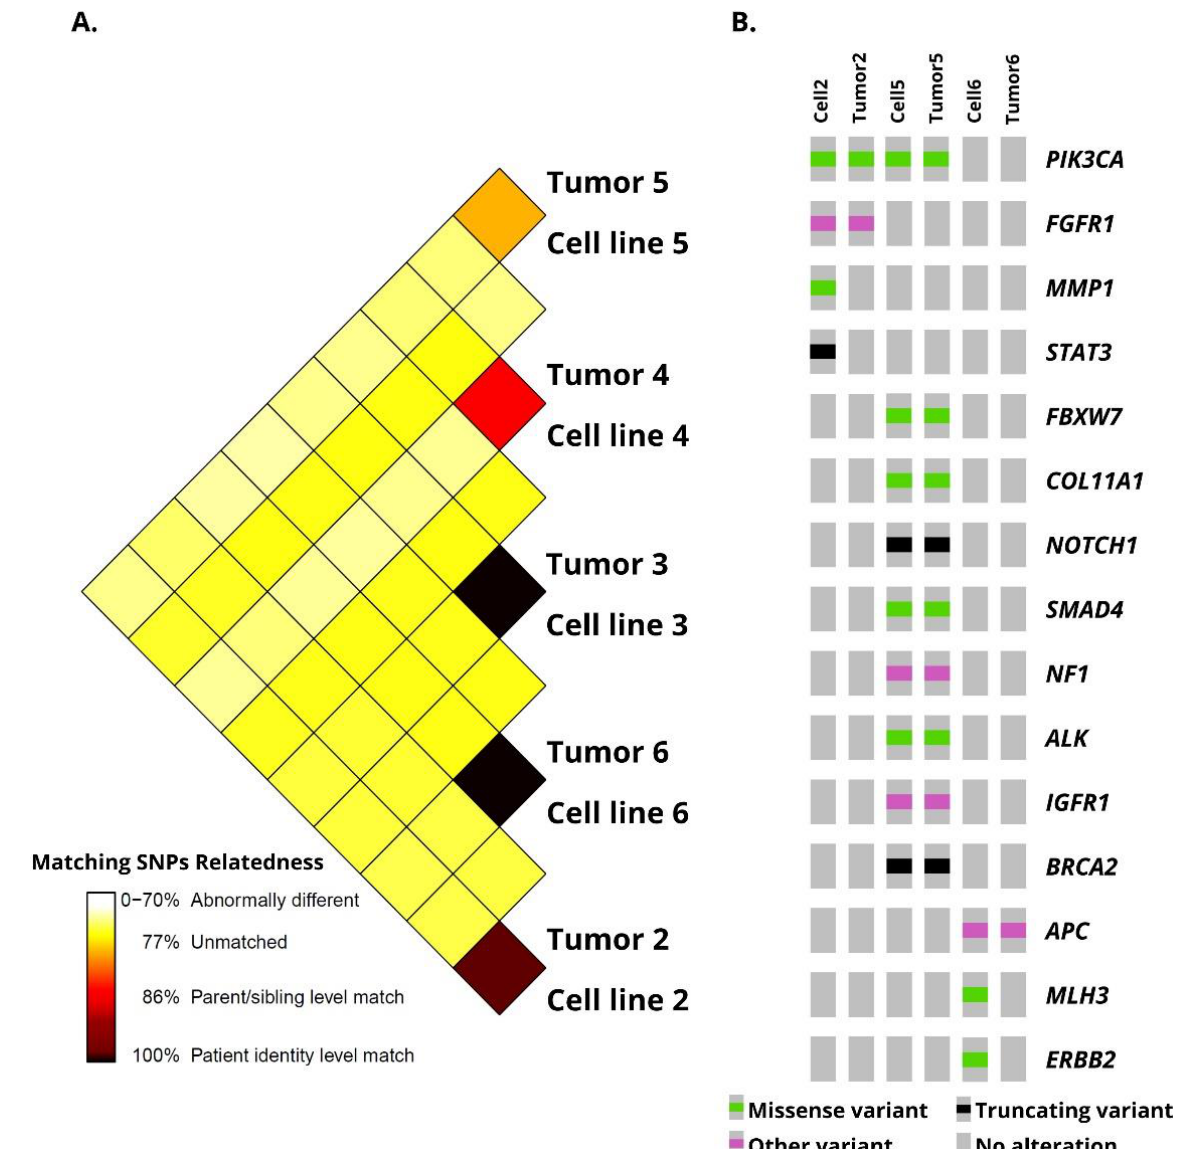
Figure 2. Genomic comparison of penile cancer (PeCa) samples and their derived cells ( A ) Sample identity distogram showing the degree of similarity among penile cancer-derived cells and their primary tumor tissue. ( B ) Variants identified by targeted next-generation sequencing in PeCa and derived PeCa cells. DNA from PeCa 3 and 4 were not available for this analysis. Oncoprint was generated by the cBioportal Oncoprinter tool (http://www.cbioportal.org/oncoprinter, accessed on 6 April 2021).